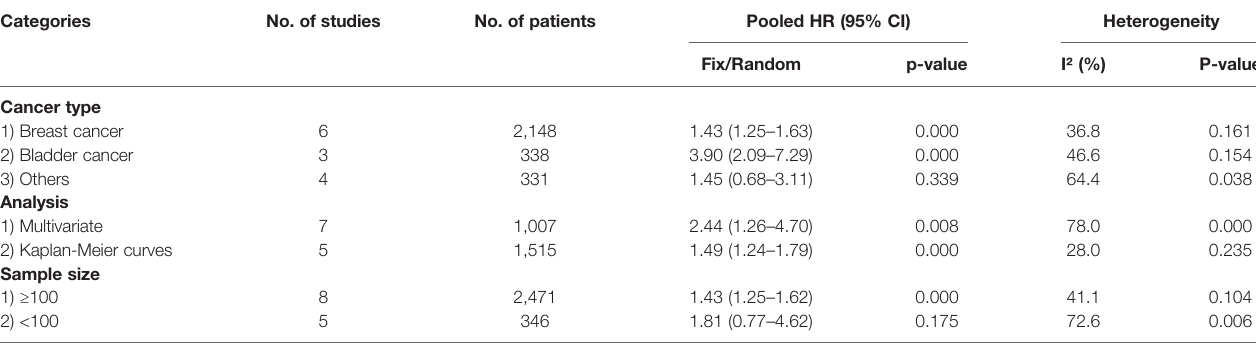
TABLE 2 | Subgroup analysis of pooled HR for OS/DFS/RFS/PFS.